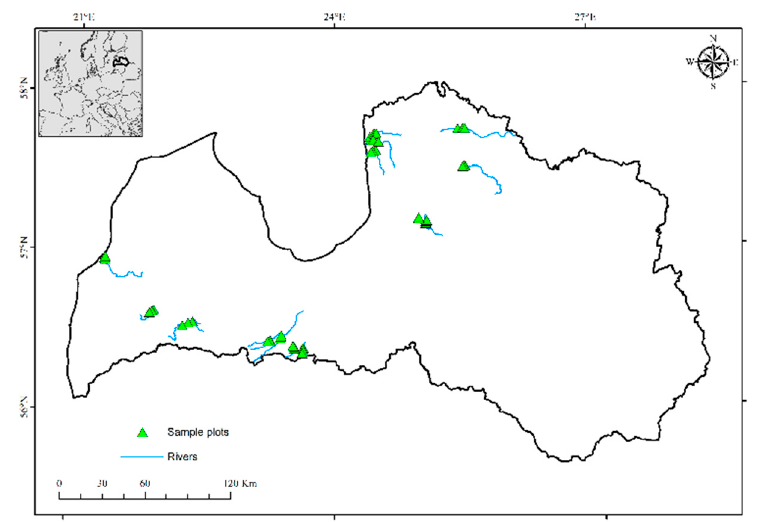
Figure 1. Location of selected sample plots and streams.